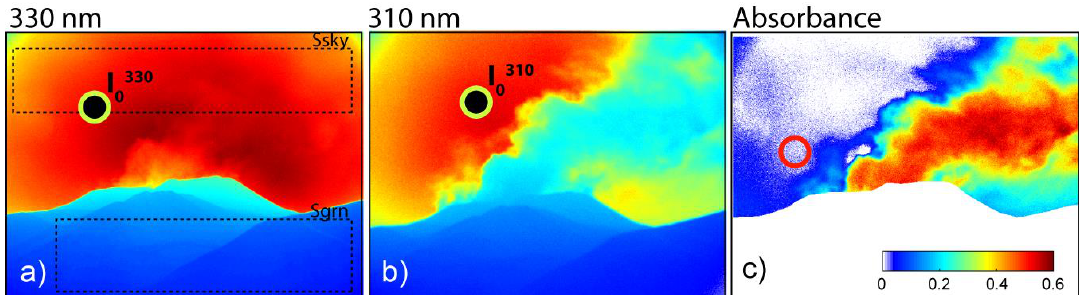
Figure 2. Calculation of the SO 2 column densities using the dual camera method with 330 nm ( a ) and 310 nm ( b ) optical filters. Absorbance image ( c ) is obtained using the Lambert-Beer equation after image normalization with respect to background absorbance intensities (black circles in ( a ) and ( b ), automatically located). Black circles in ( a ) and ( b ) represent the sky areas where absorbance is assumed to be SO 2 free (minimum absorbance level). Black rectangles ( Ssky Sgrn ) in ( a ) represent the areas used for calculation of the visibility index. The red circle in ( c ) shows the FOV of co-located UV-scanning spectrometer used to convert un-calibrated absorbance intensities into SO 2 column